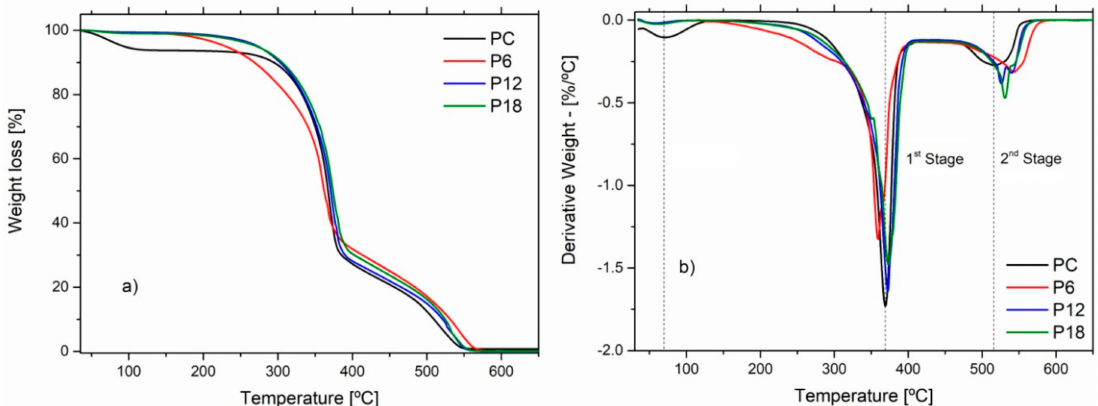
Figure 6. Curves obtained from the thermal analysis for the di ff erent samples: ( a ) Thermogravimetric curves pinewood samples, ( b ) derivative thermogravimetric curves pinewood